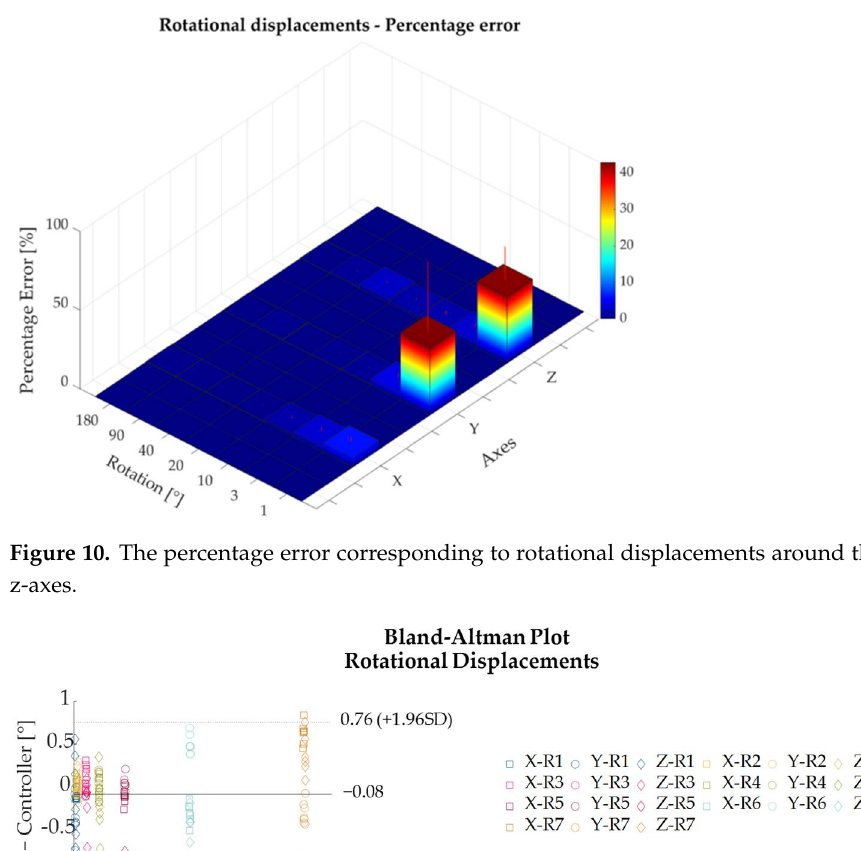
Figure 9. Absolute error corresponding to rotational displacements around the x-, y-, and z-axes.